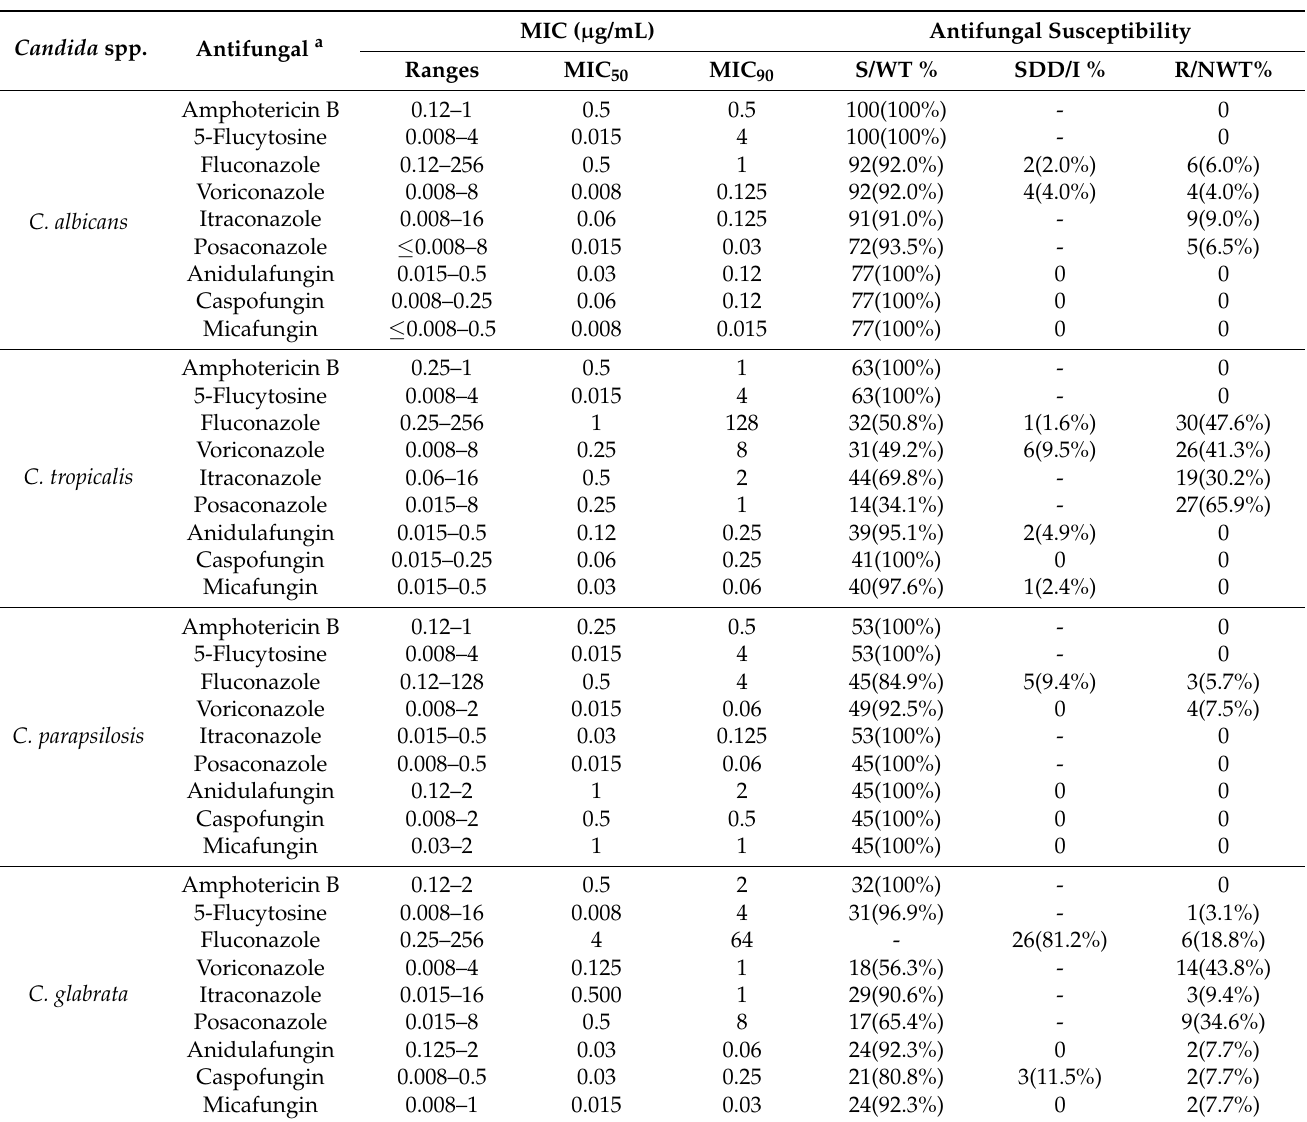
Table 1. Antifungal susceptibility of Candida species in bloodstream infections from 2016 to 2020. Candida